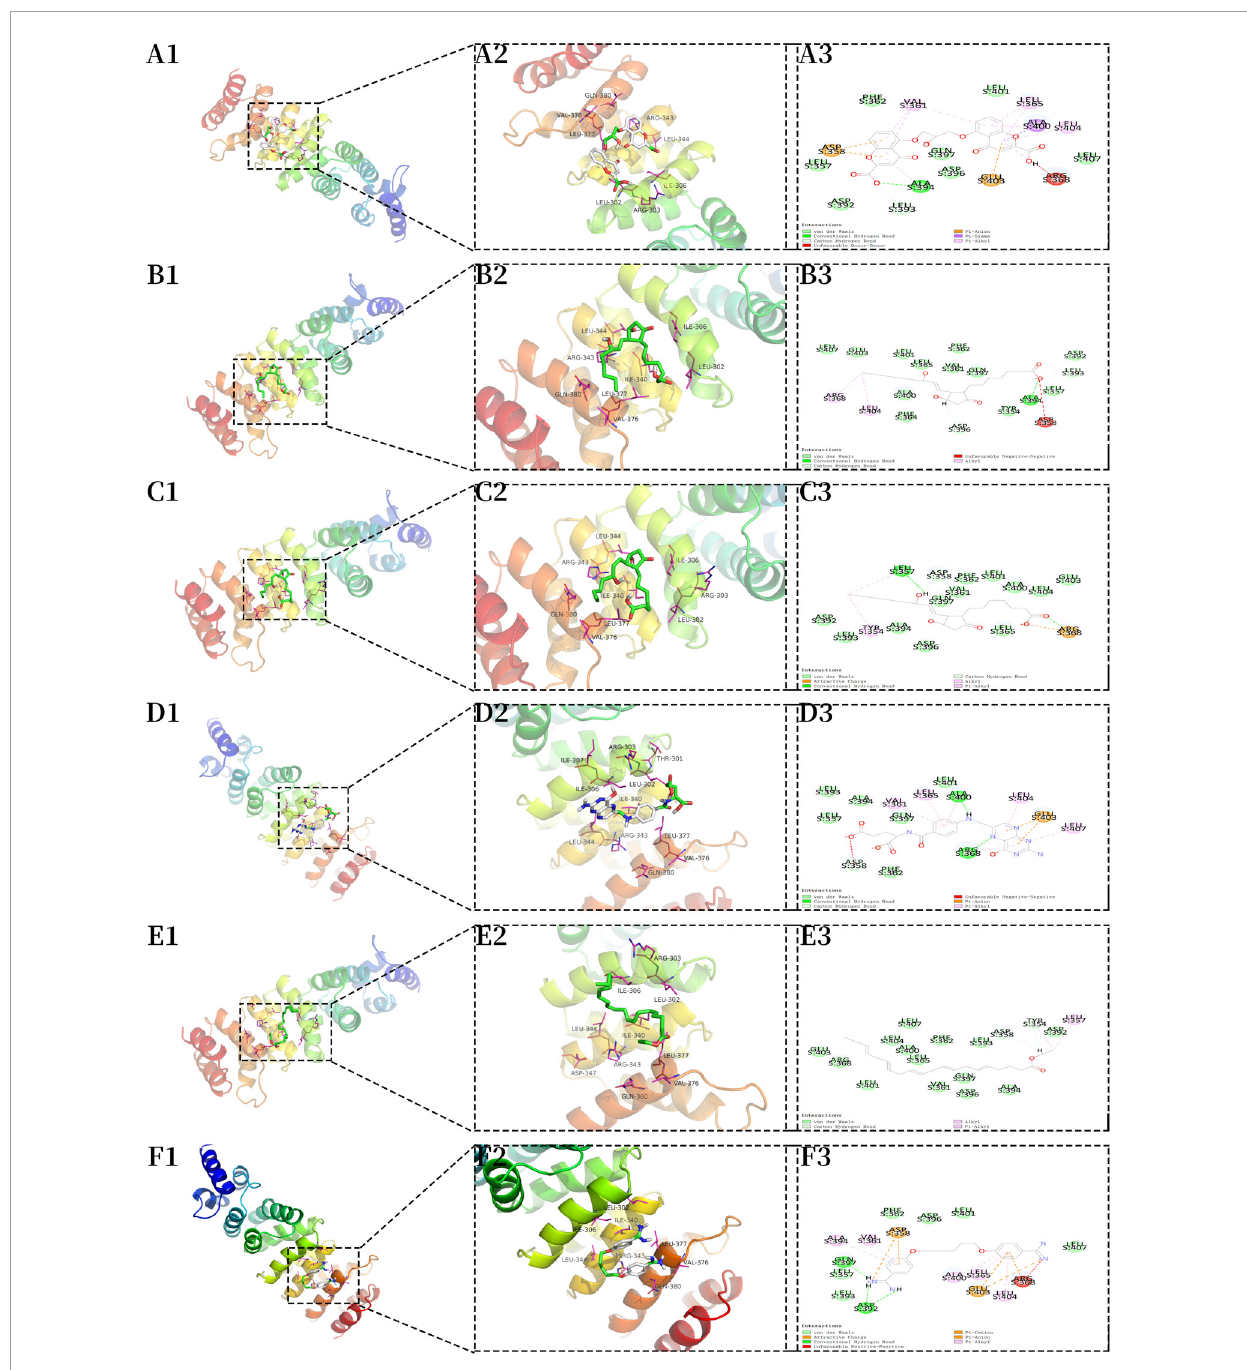
FIGURE4 Molecular docking of the core protein WDR43. (A) A1, 3D model of WDR43–cromolyn (macroscopic); A2, 3D model of WDR43–cromolyn (microscopic); A3, 2D model of WDR43–cromolyn. (B) B1, model of WDR43–edex (macroscopic); B2, 3D model of WDR43–edex (microscopic); B3, 2D model of WDR43–edex. (C) C1, 3D model of WDR43–caverject (macroscopic); C2, 3D model of WDR43–caverject (microscopic); C3, 2D model of WDR43–caverject. (D) D1, 3D model of WDR43–pga (macroscopic); D2, 3D model of WDR43–pga (microscopic); D3, 2D model of WDR43–pga. (E) E1, 3D model of WDR43–epa-e (macroscopic); E2, 3D model of WDR43–epa-e (microscopic); E3, 2D model of WDR43–epa-e. (F) F1, 3D model of WDR43–pentamidine (macroscopic); F2, 3D model of WDR43–pentamidine (microscopic); F3, 2D model of